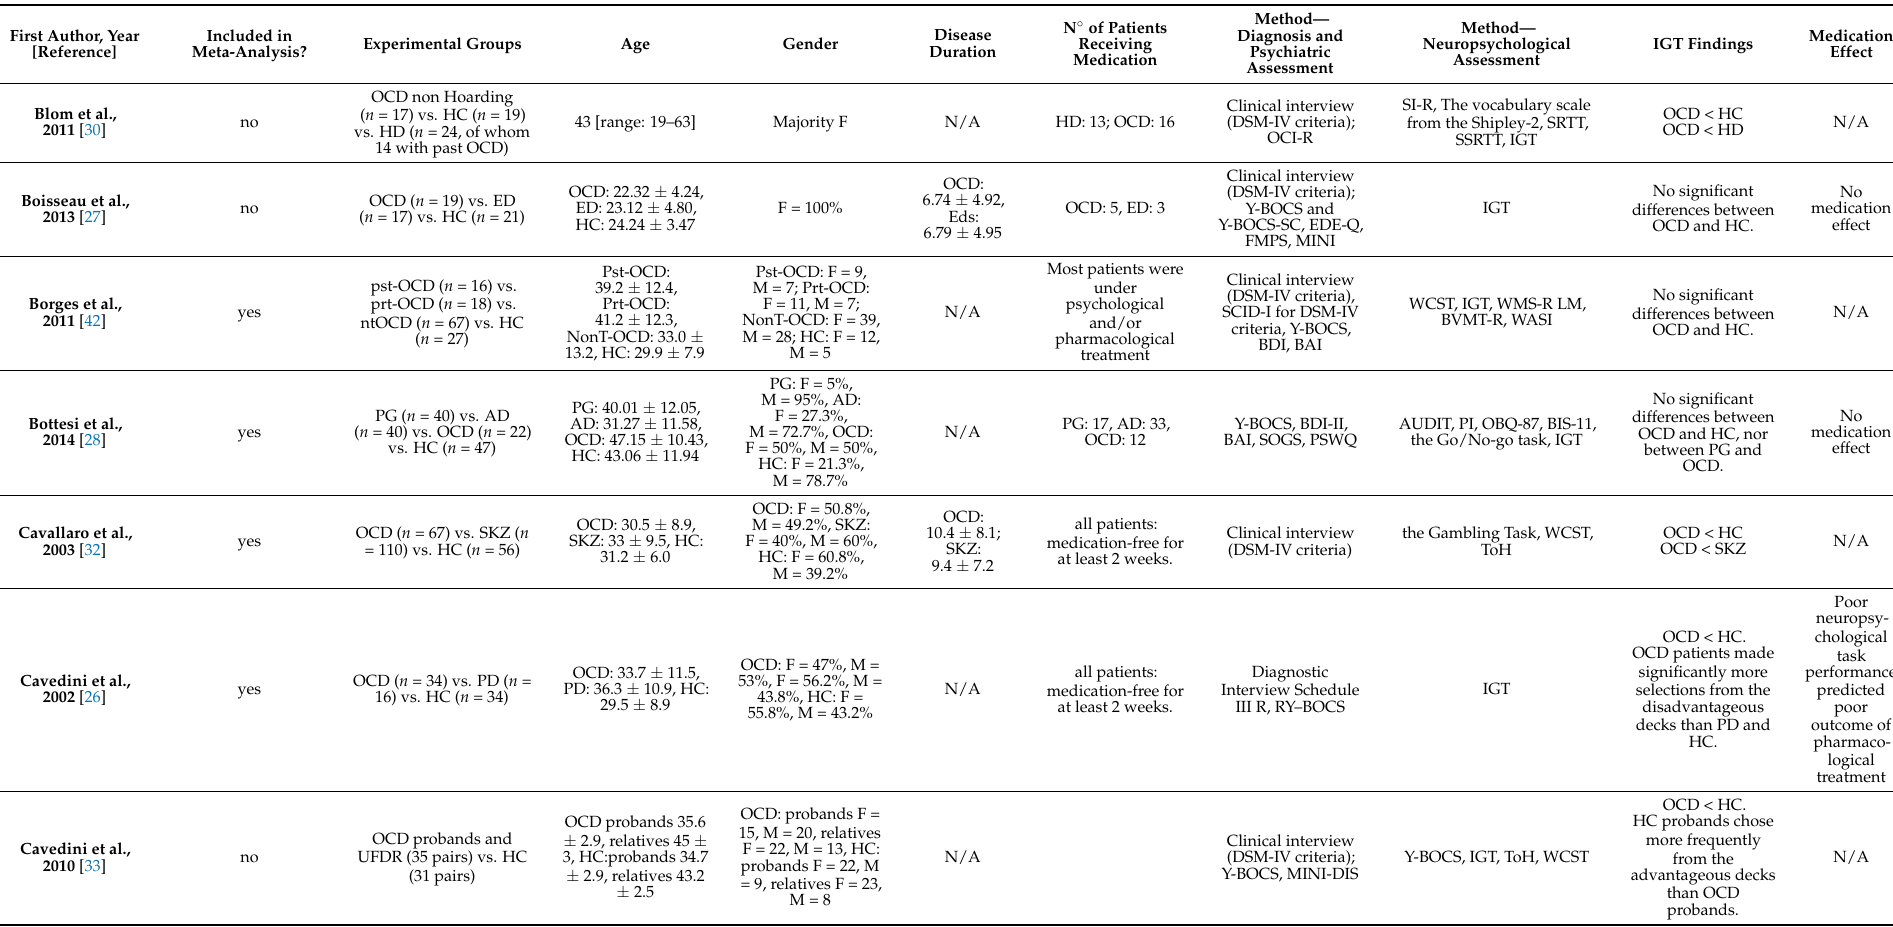
Table 1. Studies included in the systematic